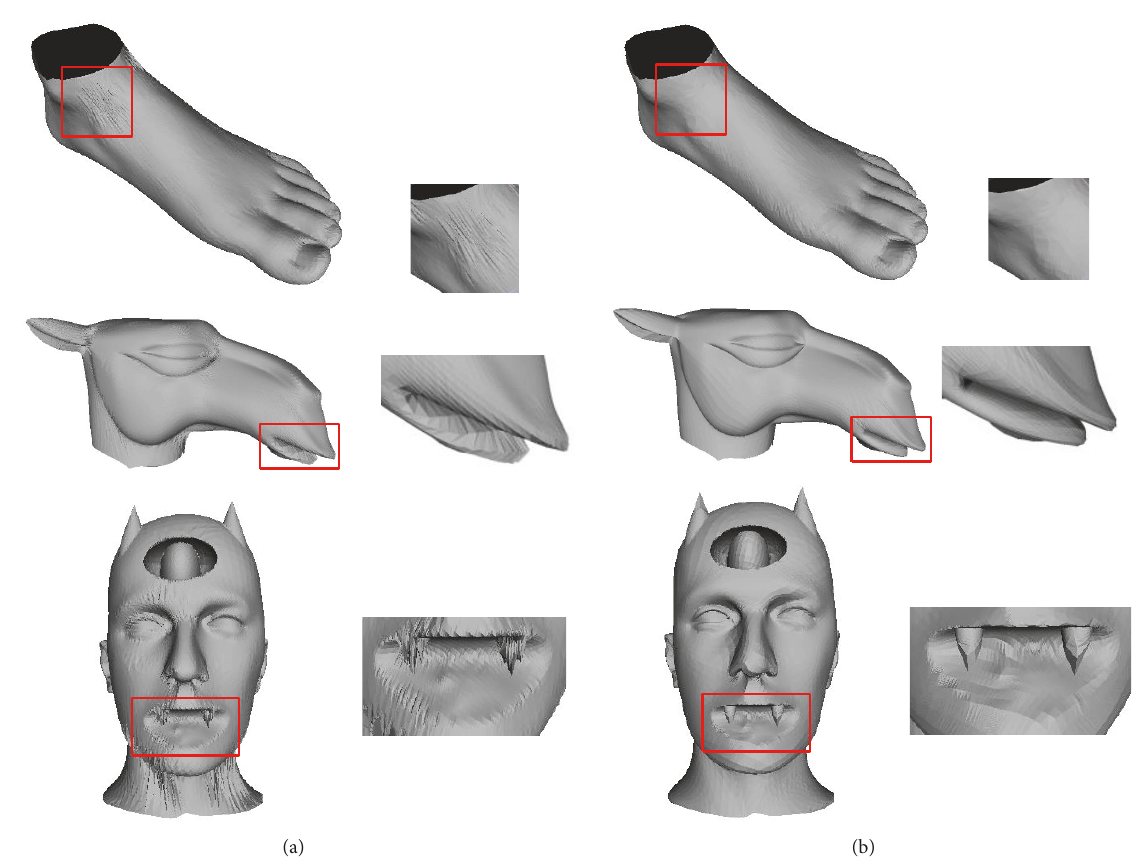
Figure 9: Qualitative results of regular sampling method (a) and our method